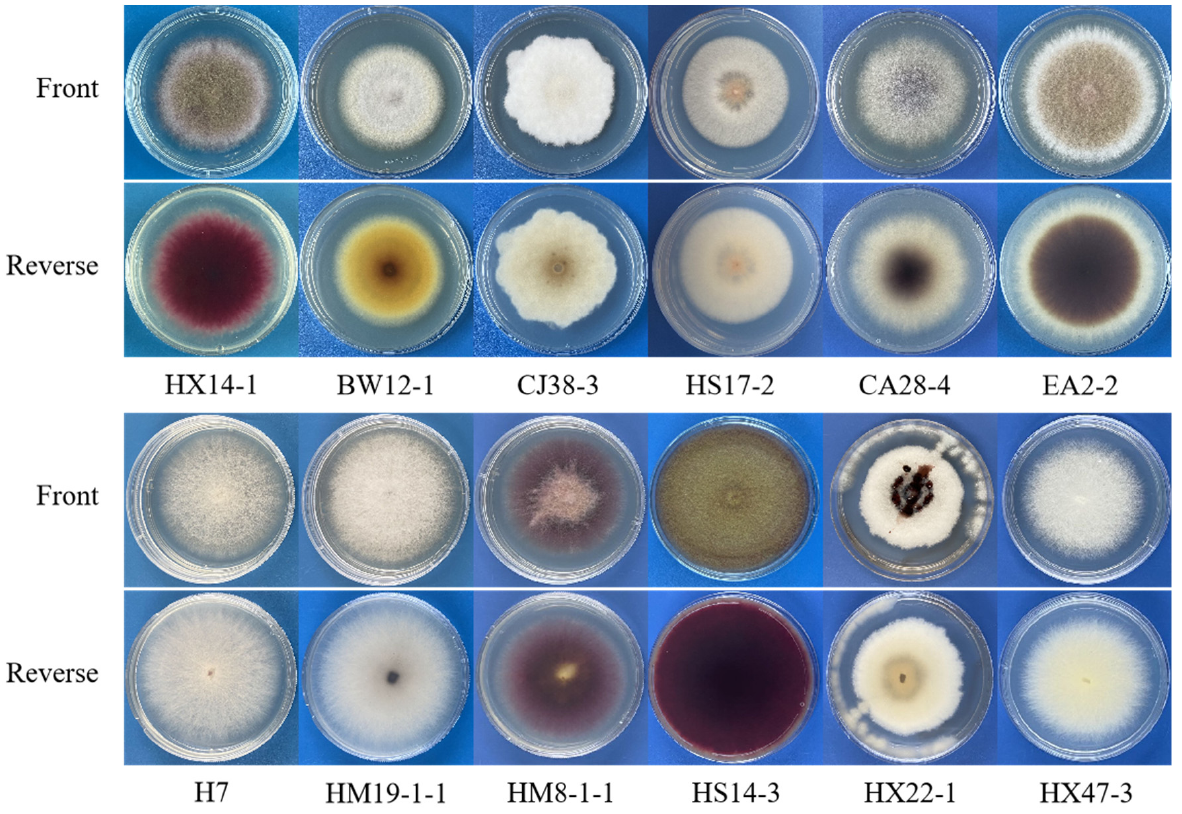
Figure 1. The morphological characteristics of the isolates after six days of incubation at 25 °C on PDA plates.